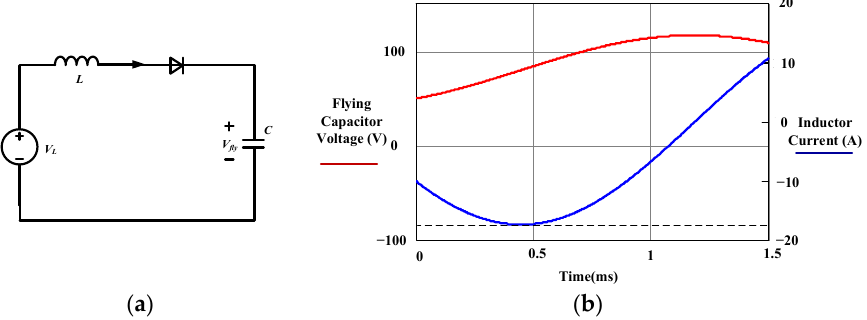
Figure 14. The analysis of the stages under S 4 fault. ( a ) Equivalent circuit; ( b ) the simulation curve (V L 80 V, V H 100 V, initial value of I L 10A).